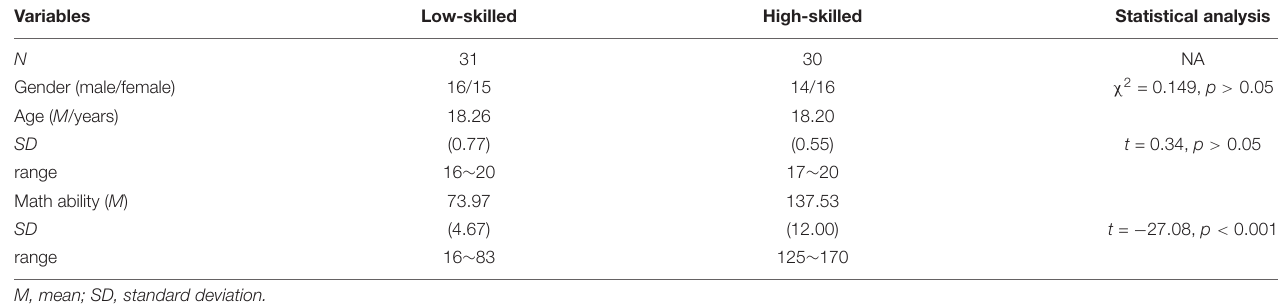
TABLE 1 | Demographic characteristics in the two groups.